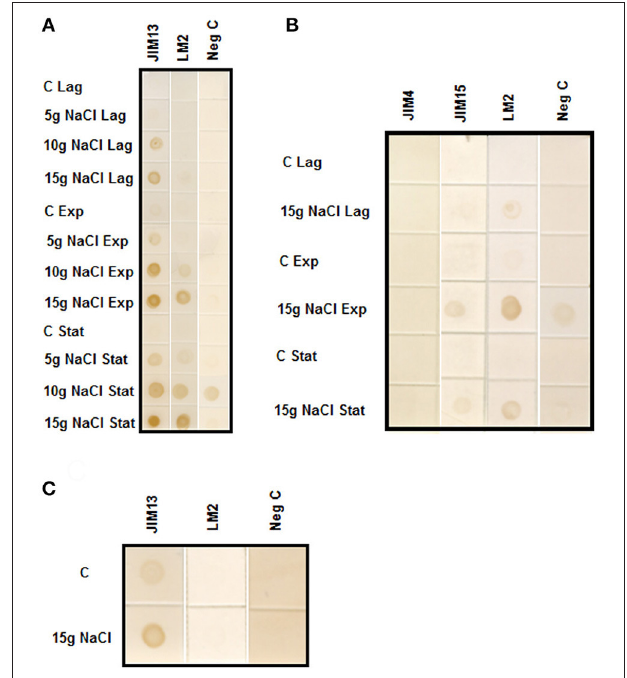
FIGURE 1 | (A) Immuno-dot blot analysis with JIM13 and LM2 antibodies on samples prepared from culture medium of control and tobacco BY-2 cells adapted to growth in 0, 5, 10, and 15 gL − 1 of NaCl. Samples were collected from culture medium of cells growing at Lag, Exponential (Exp) and Stationary (Stat) phases. (B) Immuno-dot blot analysis with JIM15, JIM4, and LM2 antibodies on samples prepared from culture medium of control and 15 gL − 1 salt-adapted tobacco BY-2 cells. Samples were collected from culture medium of cells growing at Lag, Exponential (Exp) and Stationary (Stat) phases. (C) Immuno-dot blot analysis of arabinogalactan protein release from control and tobacco BY-2 cells adapted to growth in 15 gL − 1 of NaCl. The same weight of washed cells from control and adapted cells were cultured in fresh medium. After 24h, cells were centrifuged and culture media were assayed with JIM13 and LM2